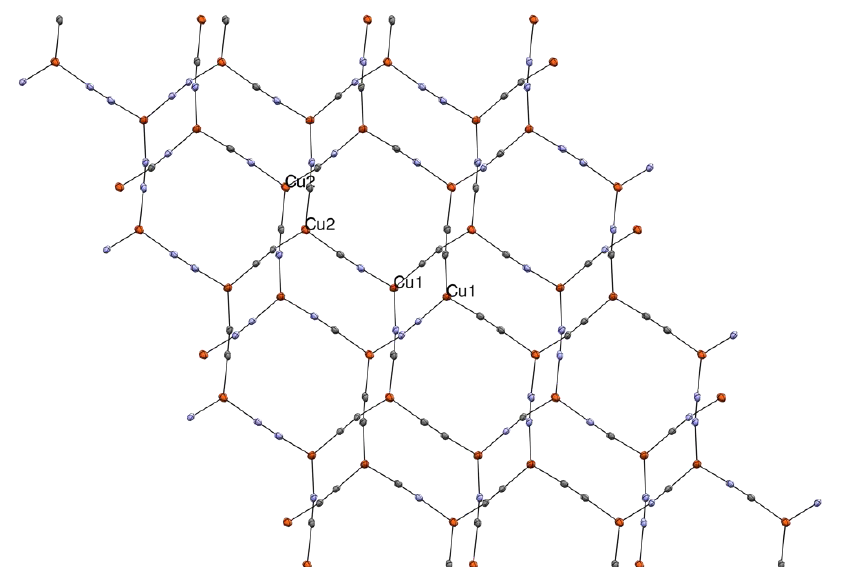
Figure 4. Thermal ellipsoid (50% probability) packing diagram of 3 , projected along the c -axis, showing network formation. Me 4 N + cations omitted for clarity. Cu orange, N blue, C grey. Selected bond lengths and angles (X = disordered C / N): Cu1-X1 1.9311(17), Cu1-X2 1.9485(16), Cu1-X3 1.9421(16), Cu2-X1 1.9398(17), Cu2-X2 1.9656(16), Cu2-X3 1.9645(16), X1-X1 1.170(2), X2-X2 1.169(2), X3-X3 1.168(2), X1-Cu1-X2 120.90(6), X1-Cu1-X3 121.44(6), X2-Cu1-X3 117.17(6), X1-Cu2-X2 119.63(6), X1-Cu2-X3 120.28(6), and X2-Cu2-X3 114.38(6). Table 1. Crystal and structure refinement data. a.